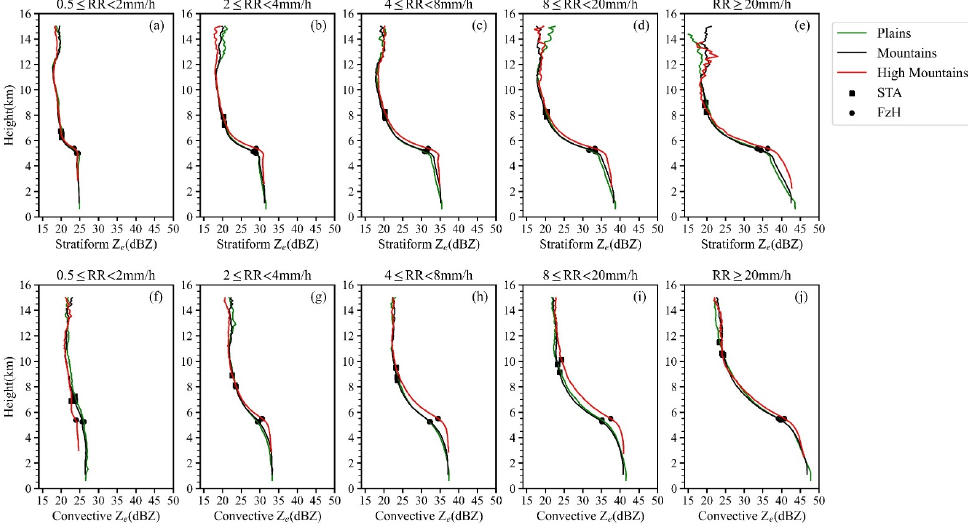
Figure 5. The vertical profile of Z e with various near-surface RR. ( a – e ) represent SP (top panels), ( f – j ) represent CP (bottom panels). The green, black and red solid lines represent plains, mountains and high mountains, respectively. The square and round dots represent STA and FzH, respectively.